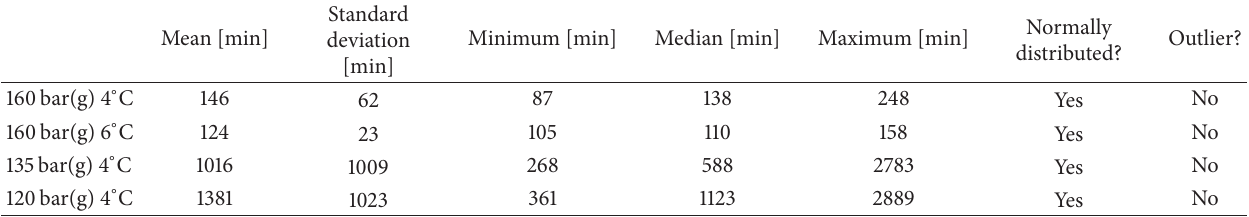
Table 4: Statistical parameters of four exemplary series of